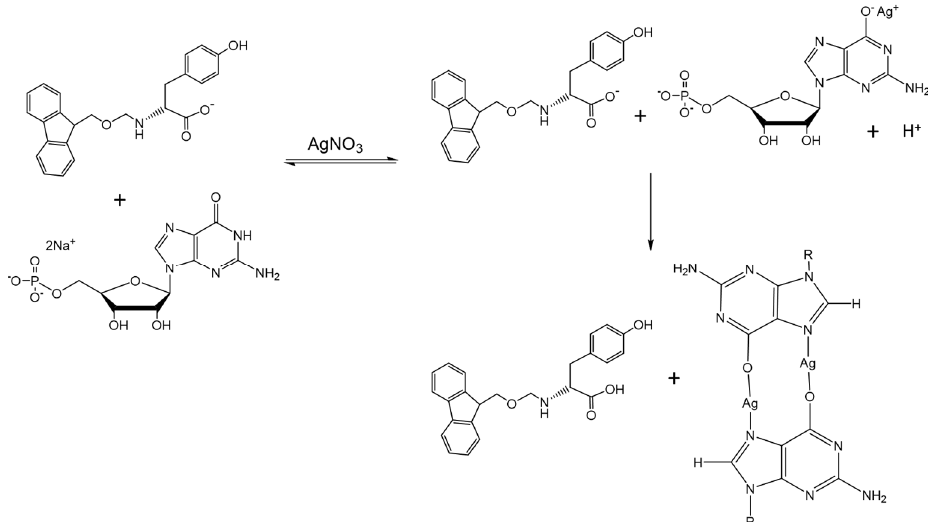
Figure 1. Schematic illustrating the formation of multicomponent nucleotide–amino acid hydrogels through the additions of silver ions to the mixture of FMOC-Tyrosine (FY) and guanosine monophosphate (GMP) solutions.